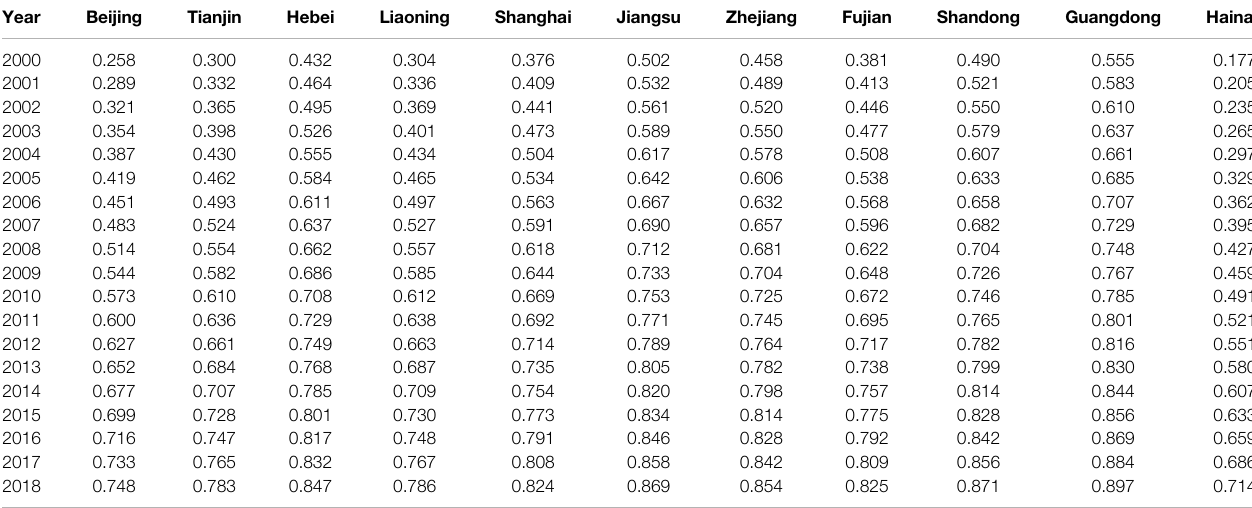
TABLE 1 | Results of TCP in eastern China from 2000 to